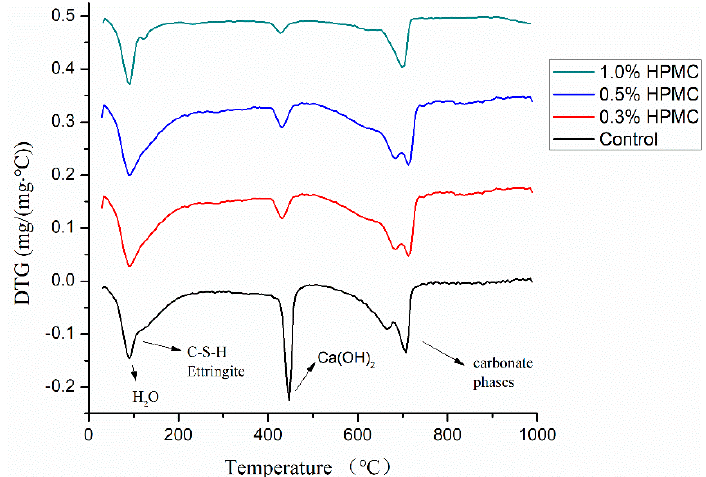
Figure 9. Di ff erential thermograms analysis (DTG) pattern of cement mortar curing for 24 h at room temperature (25 °C).